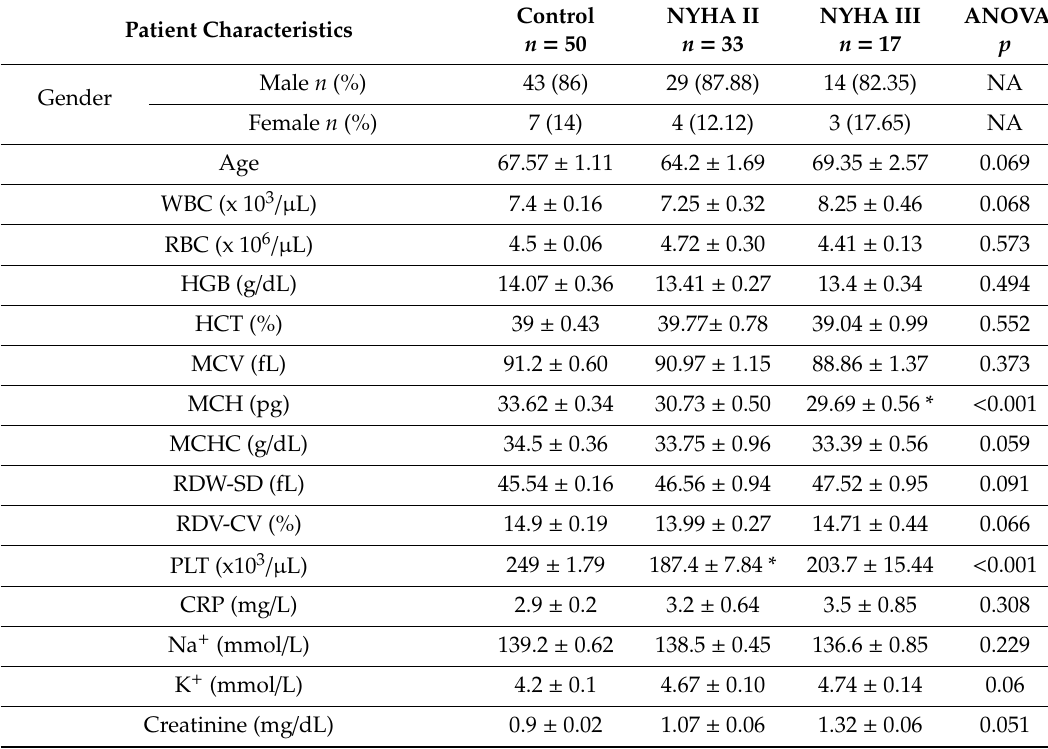
Table 1. Clinical characteristics of chronic heart failure (HF) patients and the control